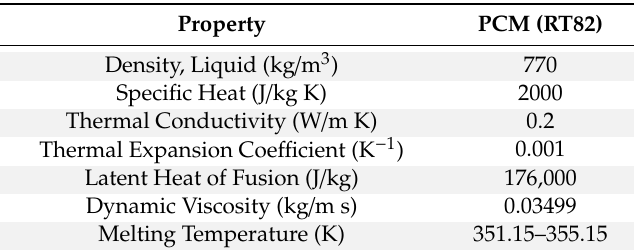
Table 1. Thermo-physical properties of phase change material (PCM), enhanced with fins, and nanoparticles [17,33].